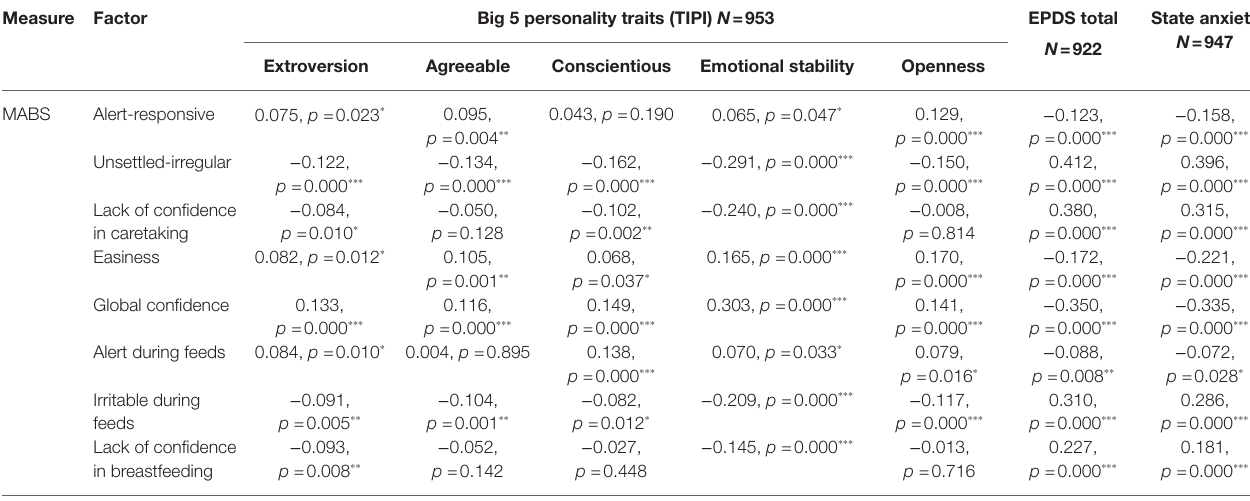
TABLE 9 | Maternal personality (TIPI), postnatal mood (EPDS), current state (STAI State) and MABS. Measure Factor Big 5 personality traits (TIPI) N = 953